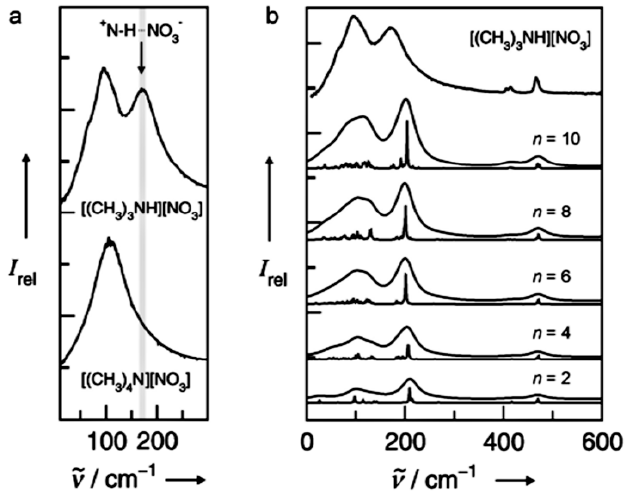
Figure 1. ( a ) Collected FIR spectra of the protic ionic liquids [(CH 3 ) 3 NH][NO 3 ] (top) and [(CH 3 ) 4 N][NO 3 ] (bottom). ( b ) Calculated FIR spectra of clusters of ion pairs of {[(CH 3 ) 3 NH][NO 3 ]} n with n = 2, 4, 6, 8, 10 [32]. Reprinted with permission of